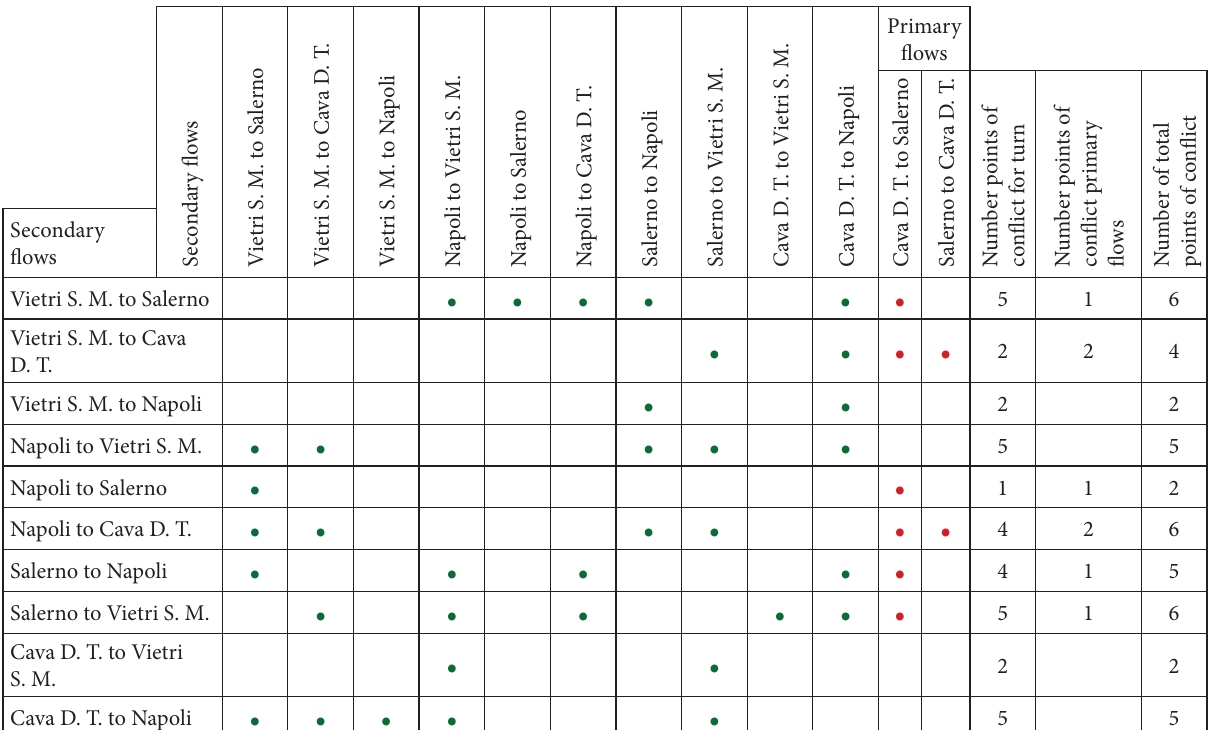
Table 1. Points of